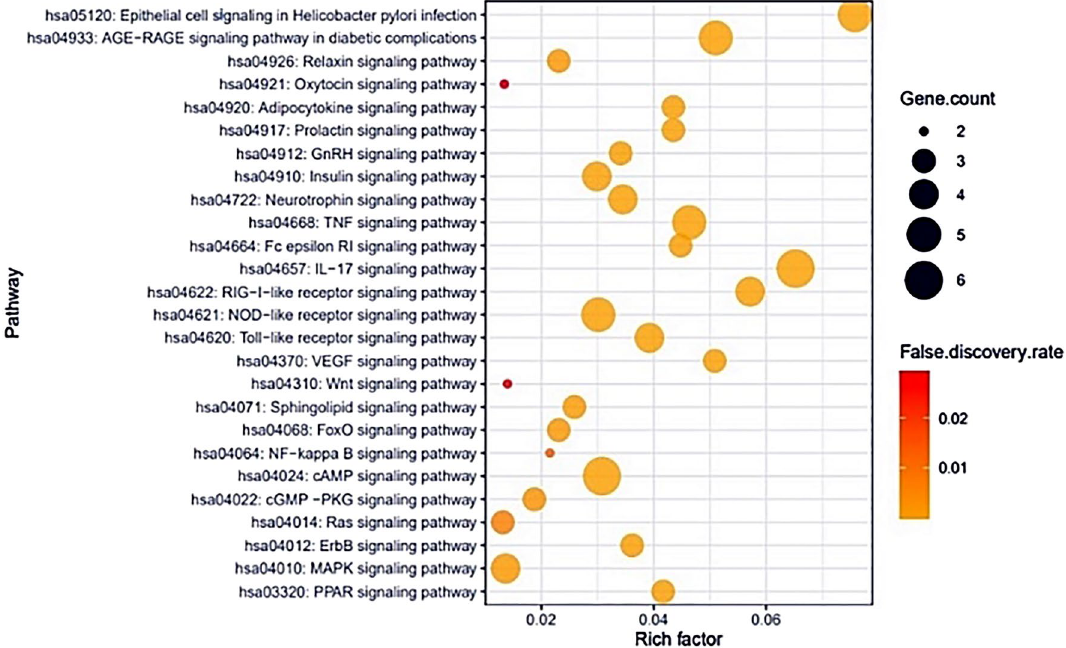
Figure 5. Bubble chart of 26 signaling pathways related to the occurrence and progression of